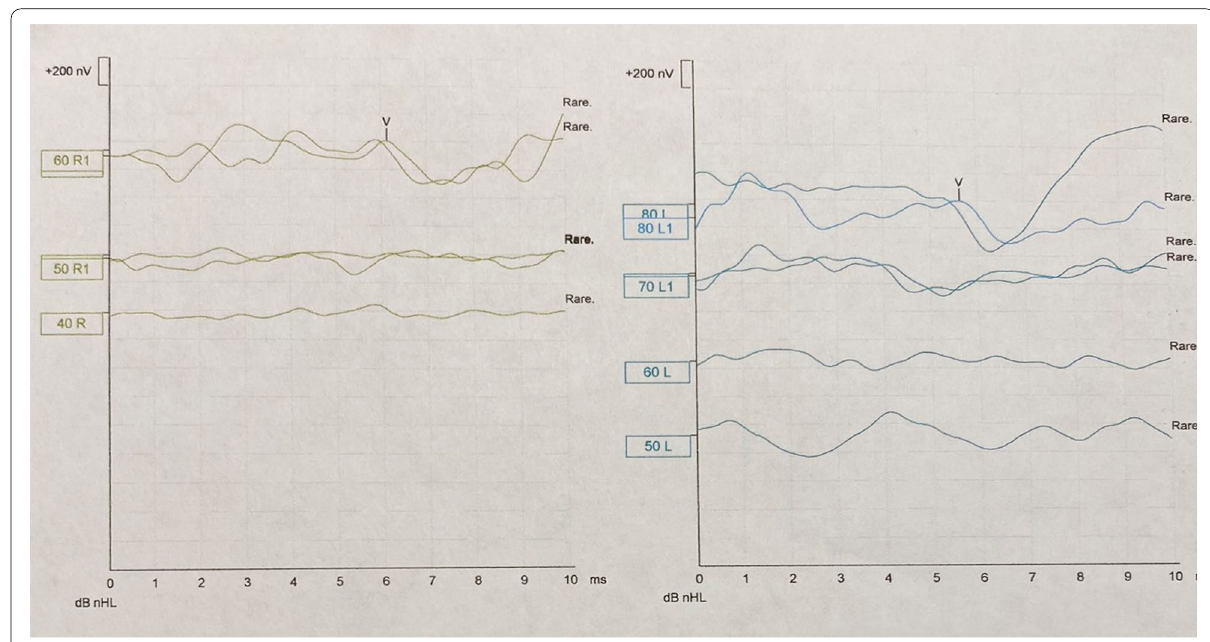
Fig. 2 Result of the ABR which was done in a different hospital